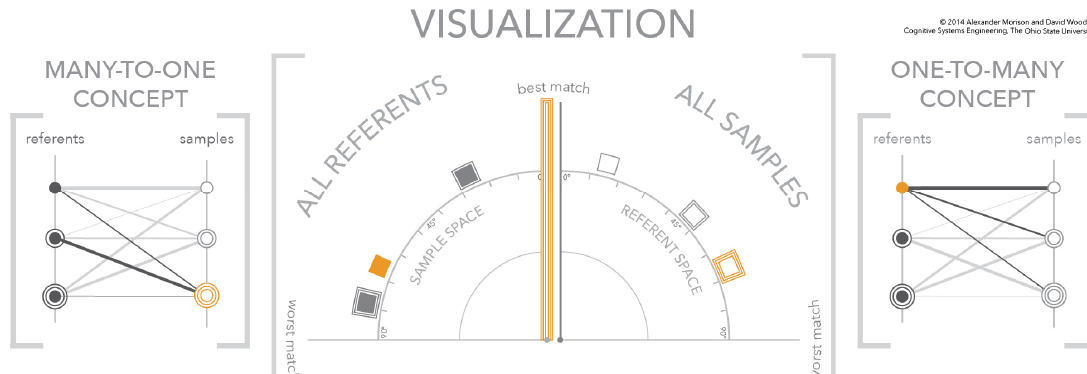
Figure 7. The third figure in a three-figure sequence showing the dynamics of the visualization. A sample is selected in the referent space—triple outlined orange box—which spreads the referents in the sample space according to the referent-sample similarity scores based on the selected sample.